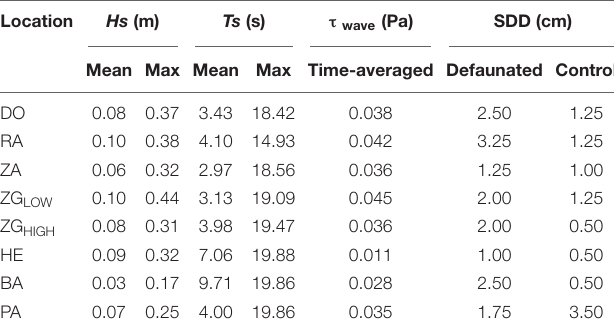
TABLE 2 | Significant wave heights ( Hs ), wave periods ( Ts) , wave-induced bed shear stress ( τ wave , time-averaged), and sediment disturbance depth (SDD) at each study location during the experiment.